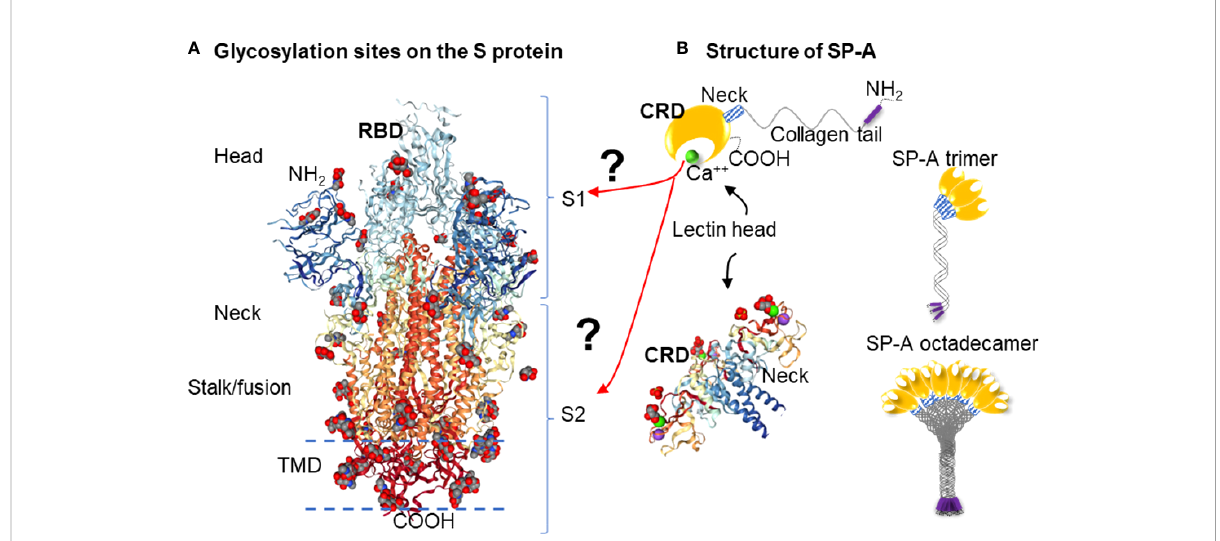
FIGURE 1 Hypothesis: SARS-CoV-2 Spike glycoprotein glycosylation sites are potential binding sites for SP-A (A) : Glycosylation sites on the SARS-CoV-2 spike glycoprotein trimer are denoted by NAG residues, shown in (O): red; (C): grey; (N): blue space fi ll balls. Structure of SARS-CoV-2 spike glycoprotein with a single receptor-binding domain up NGL Viewer (AS Rose et al. 2018) PDB: 6VSB DOI: 10.2210/pdb6VSB/pdb EM Map EMD- 21375: EMDB EMDataResource (B) : Structure of monomer (top panel), trimeric and octadecameric SP-A and potential carbohydrate recognition sites on the S protein by the Carbohydrate Recognition Domain (CRD) of the lectin head of SP-A. The CRD binds carbohydrate residues with high af fi nity in a Ca ++ dependent manner. The X-ray Crystal Structure depicts the rat Surfactant Protein A neck and carbohydrate recognition domain ligated with mannose. Atoms represented by the space fi ll balls are: (O): red; (C): grey; (Ca): green; (Na): purple. PDB: 3PAK DOI: 10. 2210/pdb3PAK/pdb 2010-11-03 Shang, F. et al. (X-RAY DIFFRACTION Resolution: 1.90 Å). (RBD, receptor binding domain; S1, Spike 1 region; S2, Spike 2 region; TMD, Transmembrane domain; CRD, Carbohydrate recognition